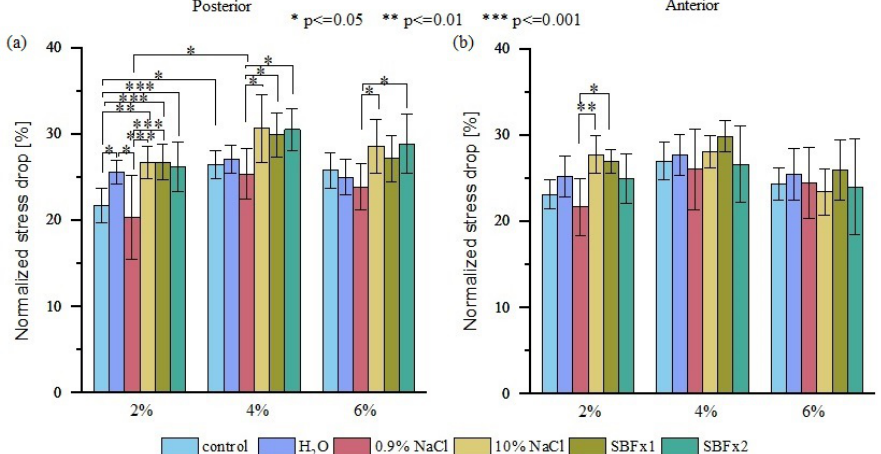
Figure 12. A comparison of normalized stress drop obtained from the ( a ) posterior side and ( b ) an- terior side of the tendon for three different strain values. The normalized stress drop given for the control group and for rehydrated samples after 15 min of rehydration in distilled water, 0.9% NaCl, 10% NaCl, SBFx1, and SBFx2, p <